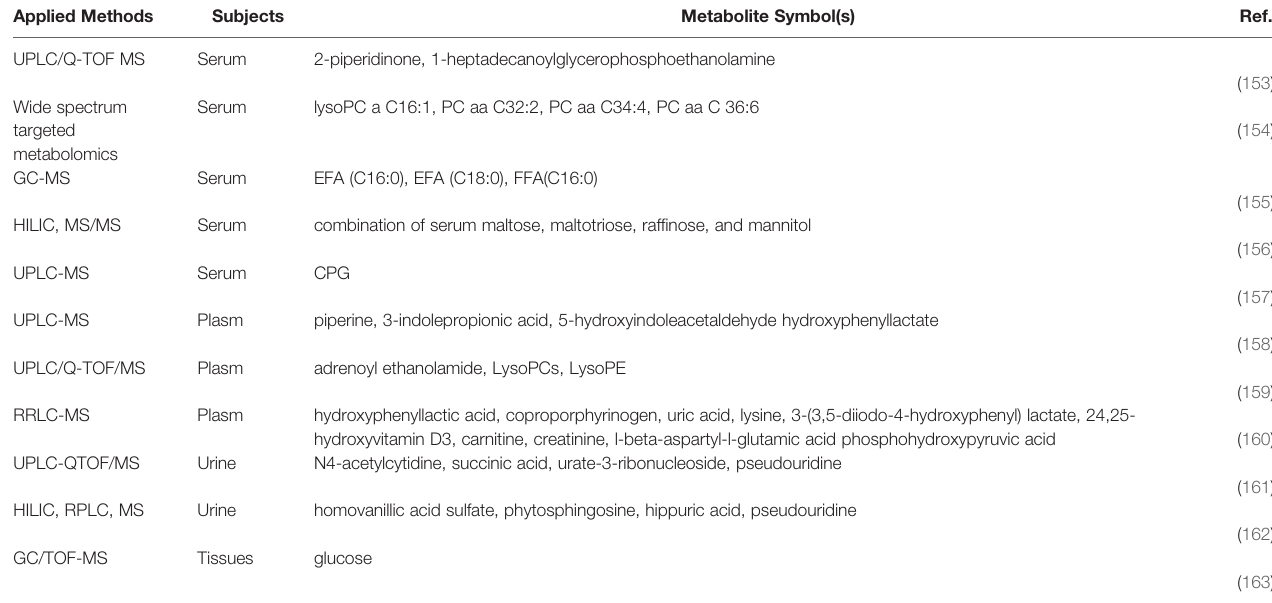
TABLE 4 | The application of metabolomics for exploring the candidate biomarkers for ovarian cancer. Applied Methods